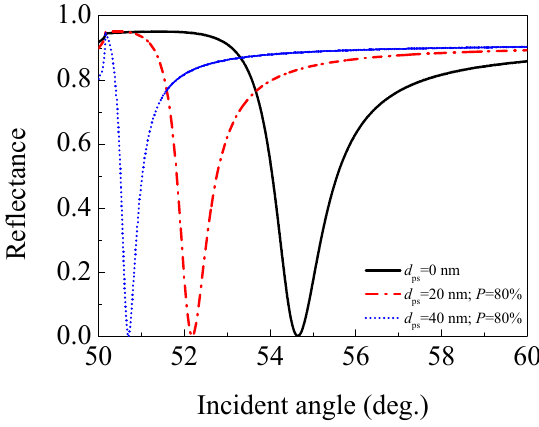
Figure 7. (Color online) The angular spectra of the SPR sensors with 0 (traditional SPR sensor), 20, and 40 nm thick 80% porosity porous silica film ( n ps = 1.086).